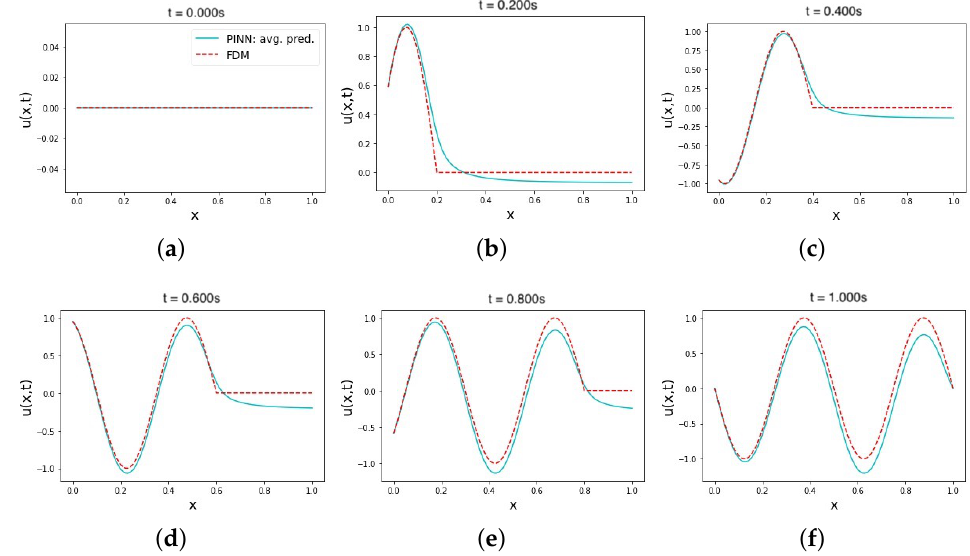
Figure 4. The average predicted solution of the wave equation using PINN with hard IC constraints and soft BCs constraints (hard–soft). Plots ( a – f ) show the average prediction values of the four most accurate trials in multiple time instances in the range [0, 1]. The six remaining trials that showed an L2 relative error ≈ > 1.0 were excluded. All training points are sampled uniformly from the domain in all